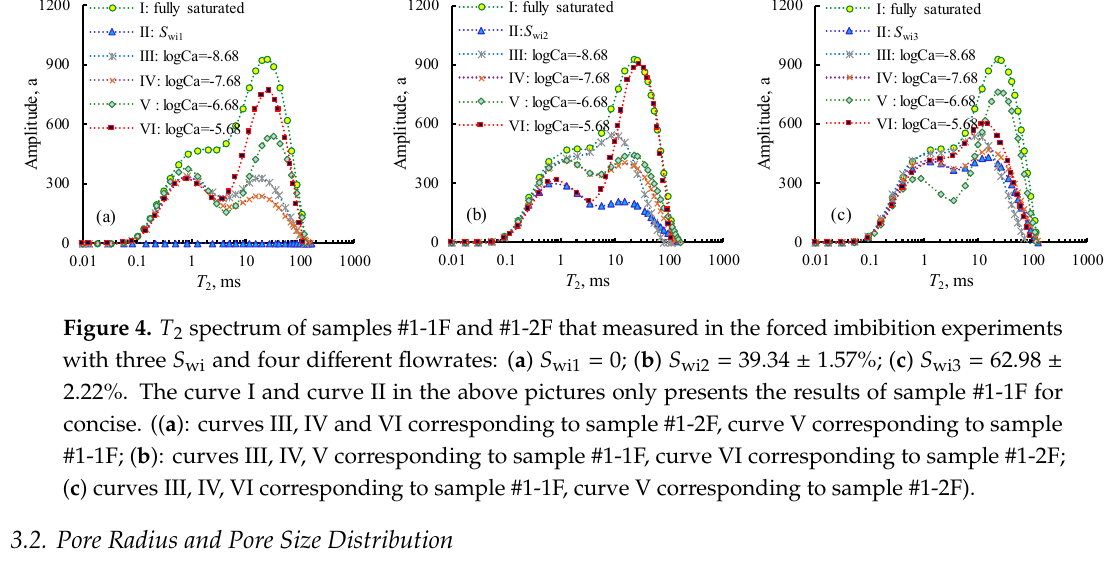
Figure 3. The T 2 spectrum of sample #1-1F that measured in the spontaneous experiments with three S wi : ( a ) S wi1 = 0; ( b ) S wi2 = 39.34 ± 1.57%; ( c ) S wi3 = 62.98 ± 2.22%.